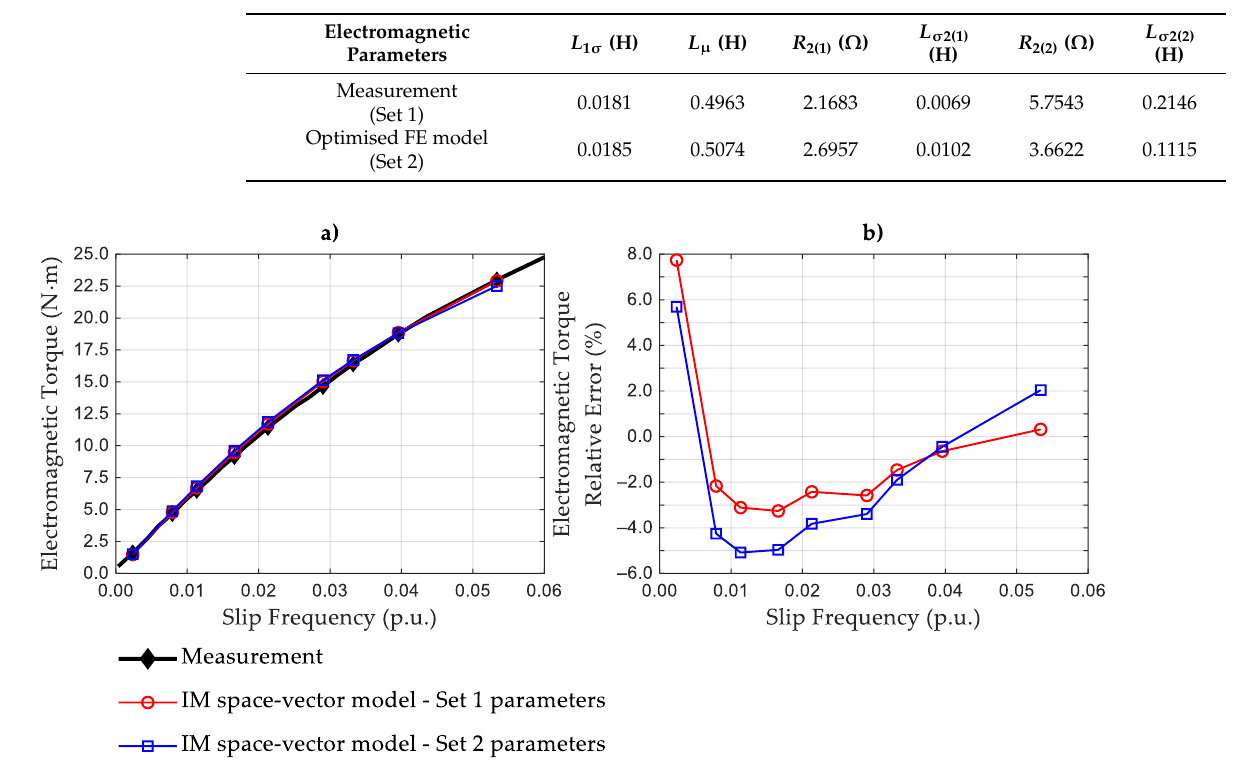
Table 5. Electromagnetic parameters of the IM equivalent circuit with two ( N = 2) parallel connected two-terminals in the rotor network representation. The resistances correspond to the reference winding temperature of 25 ◦ C.